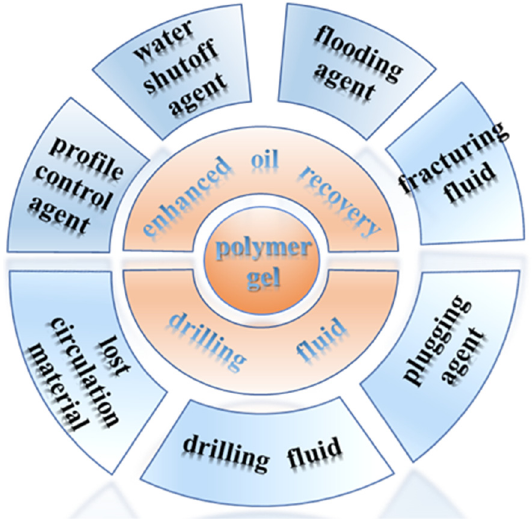
Figure 12. Application of polymer gels in oil–gas drilling engineering.